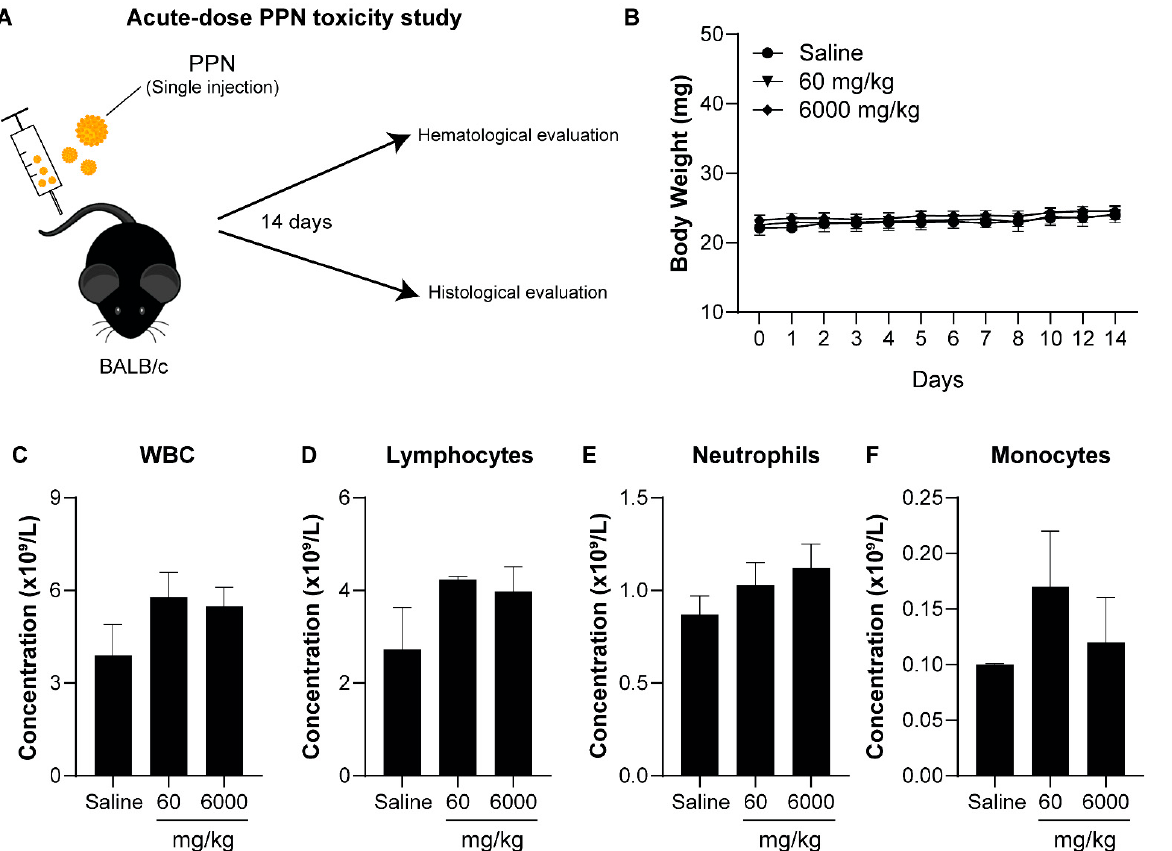
Figure 4. ( A ) Experimental schematic depicting the acute toxicity dosing of the PPNs in BALB/c mice via a single intravenous tail vein injection, followed by blood and organ analysis after 14 days. ( B ) Body weight of BALB/c mice receiving either saline or PPN doses of 60 and 6000 mg/kg over 14 days post-injection. Hematology analysis consisting of ( C ) white blood cell, ( D ) lymphocyte, ( E ) neutrophil, and ( F ) monocyte counts at 14 days post-injection. The data represent the mean ± SEM of five